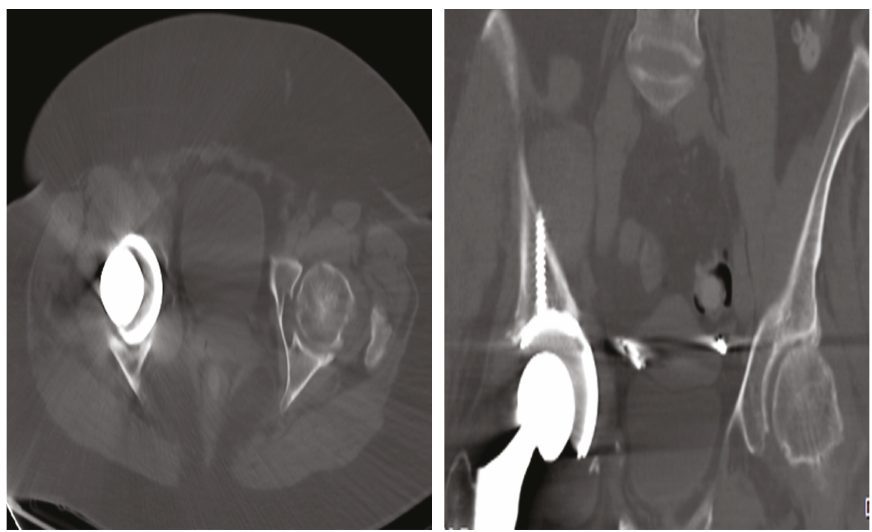
Figure 3: Axial and coronal CT scan showing excessive medialization of the acetabular component.